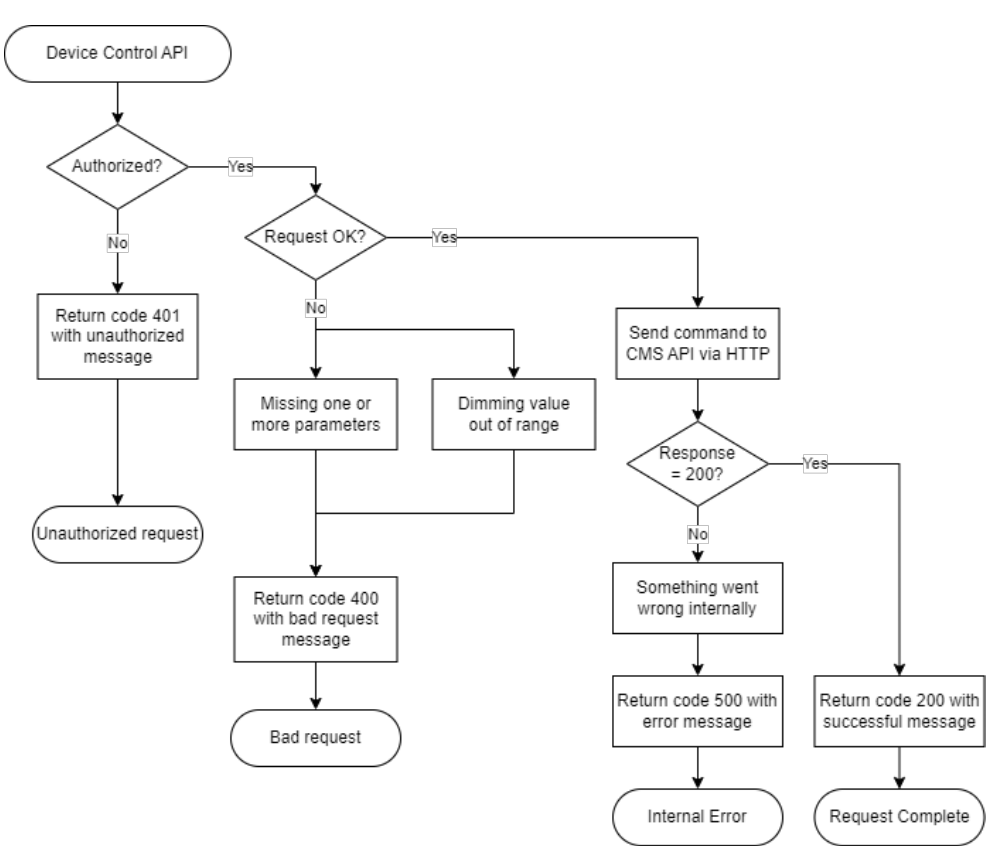
Figure 5. The flowchart shows the API process of controlling individual smart street light